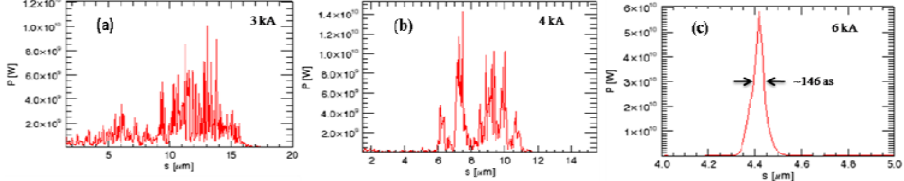
Fig. 3. (Color online) Radiation power at 0.1 nm